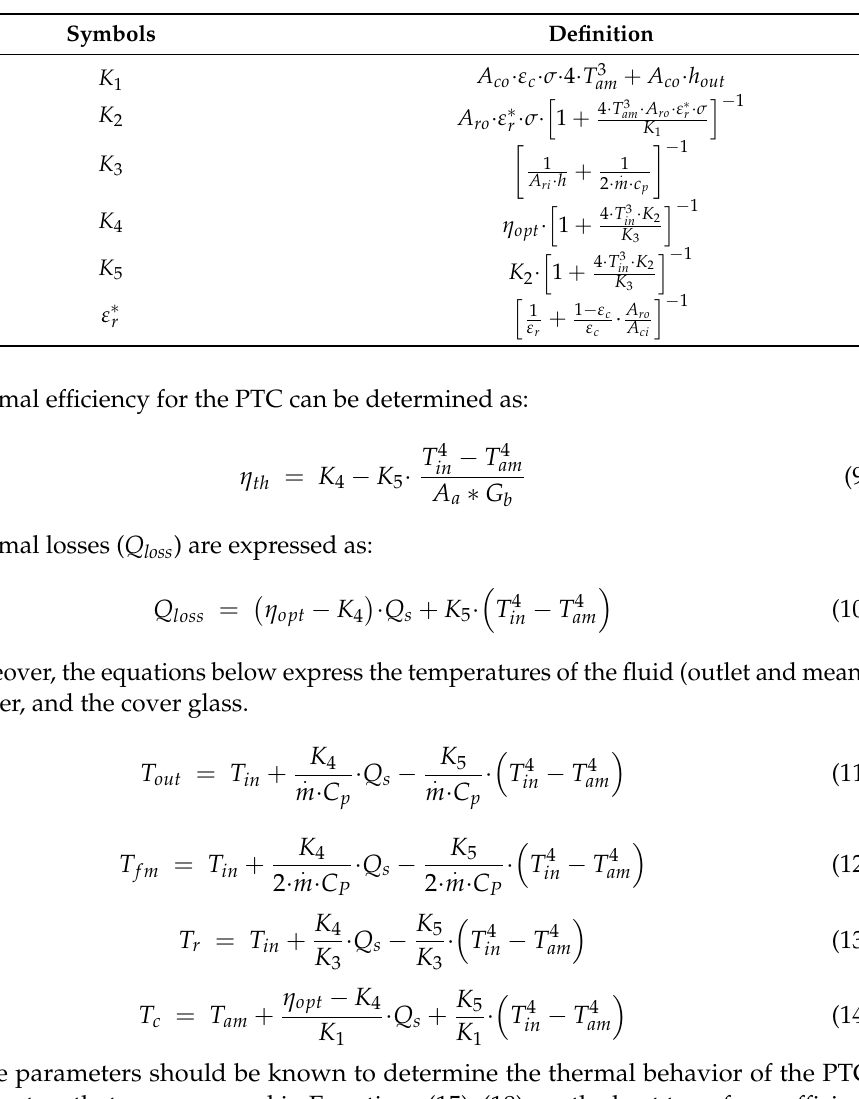
Table 4. Symbols and their definitions